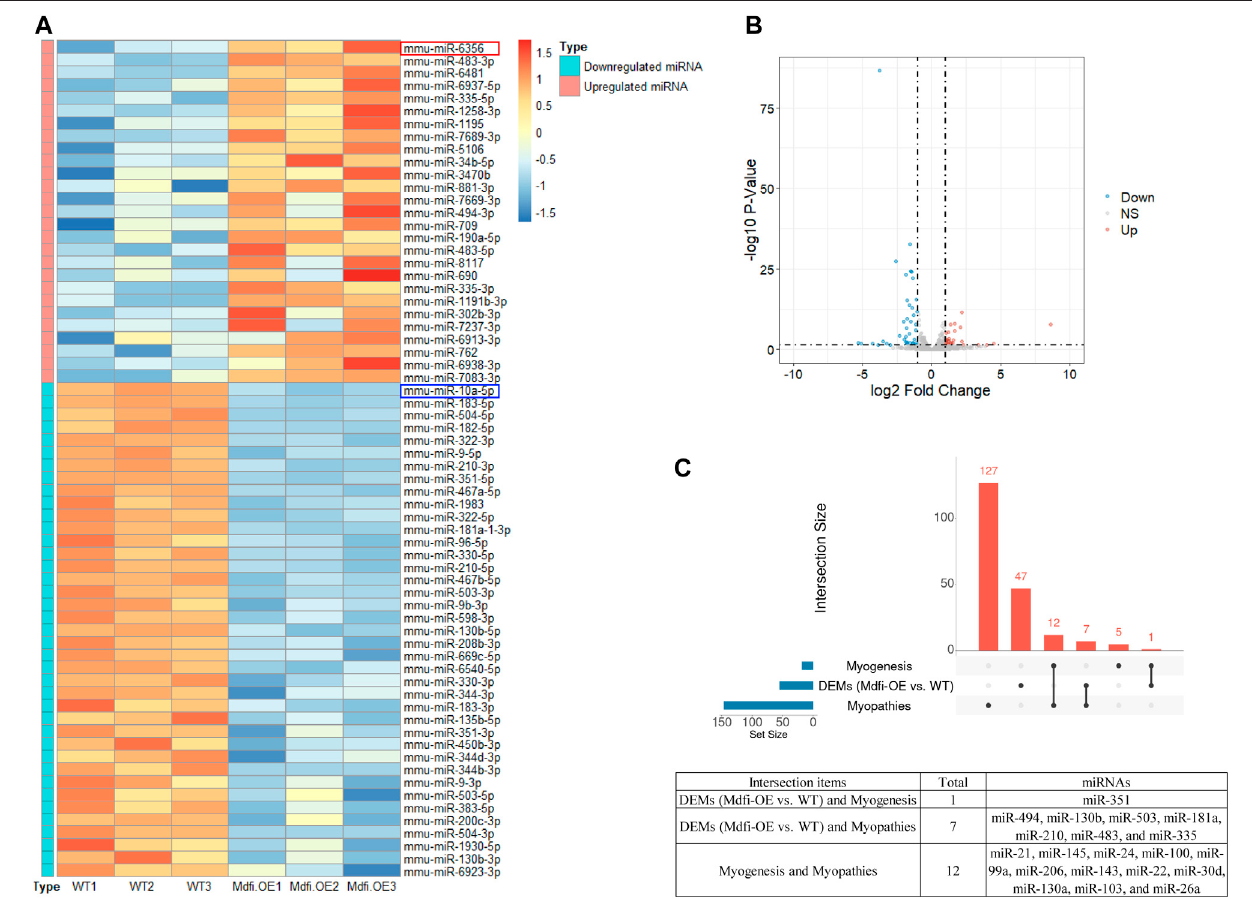
FIGURE 1 | The overview of the DEMs. ( A) . The Heatmap plot. Samples: Wild-Type 1/2/3 represent normal C2C12 cells. Md fi -Overexpression 1/2/3 represent overexpression Md fi in C2C12 cells. The types include upregulated miRNAs and downregulated miRNAs. Normalized log 2 data were hierarchically clustered by miRNAand are plotted asa heatmap. Acolor scalerepresentstherelative intensity oftheexpression ofmiRNA. Orangerepresentshigh expression and blue represents low expression. (B) . The Volcano plot. The X-axis represents log-transformed p -value, and the Y-axis indicates the multiple of the DEMs between Md fi -OE and WT groups. Note: the grey dots represent DEMs that are not differentially expressed, the red dots represent the upregulated DEMs, and the blue dots represent the downregulated DEMs. |Log2FoldChange| > 1 and p -value < 0.05 were set as the criteria. Down, NS, and Up represent the downregulated, not signi fi cant, and upregulated DEMs. (C) . The intersection analysis plot. UpSet plot of the intersection analysis of DEM, myogenesis and myopathie. The transverse bar graph at the bottom left shows the number of miRNAs. The bars above represent the number of miRNAs corresponding to each intersection.